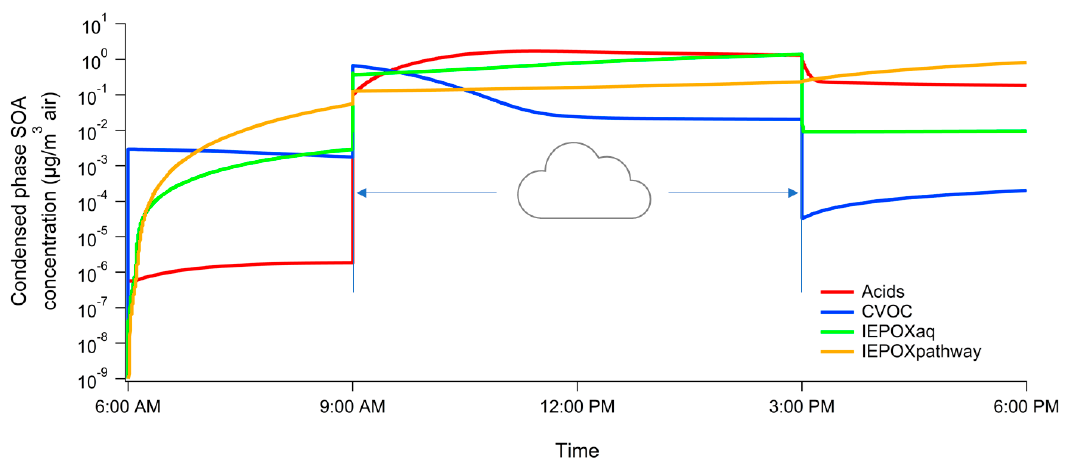
Figure 5. Organic acids, CVOCs, IEPOX, and IEPOX SOA mass concentrations in Simulation 2 with aerosol pH 1 and cloud pH 4.